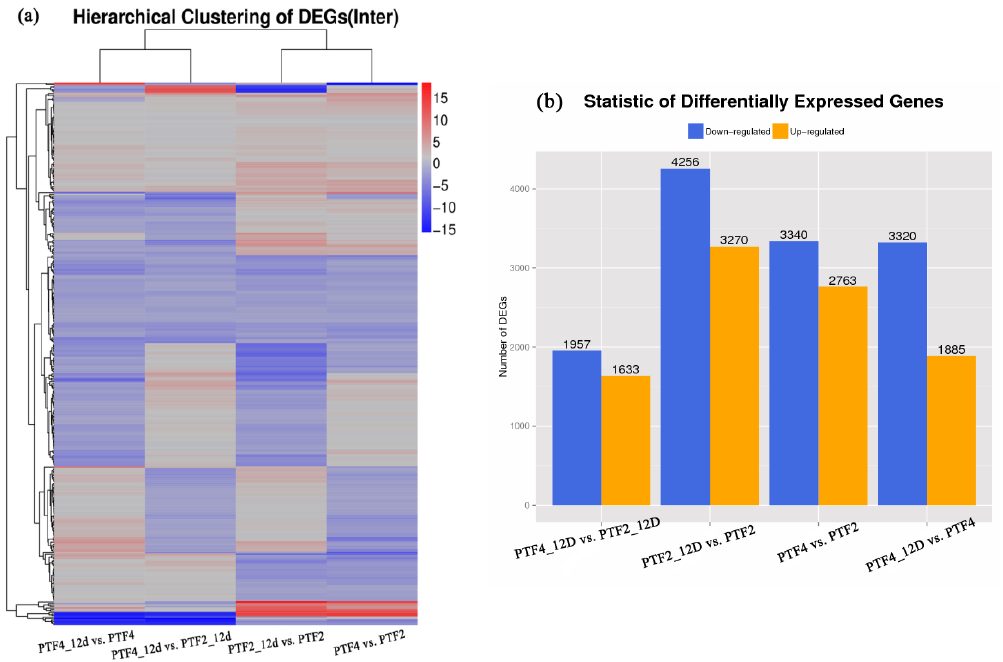
Figure 2. Statistics of gene expression in four libraries; ( a ) The cluster chart of genes expression; ( b ) The differently expressed genes in the four comparisons of PTF4_12d vs. PTF2_12d, PTF2_12d vs. PTF2, PTF4 vs. PTF2, and PTF4_12d vs. PTF4. DEGs: differentially expressed genes.